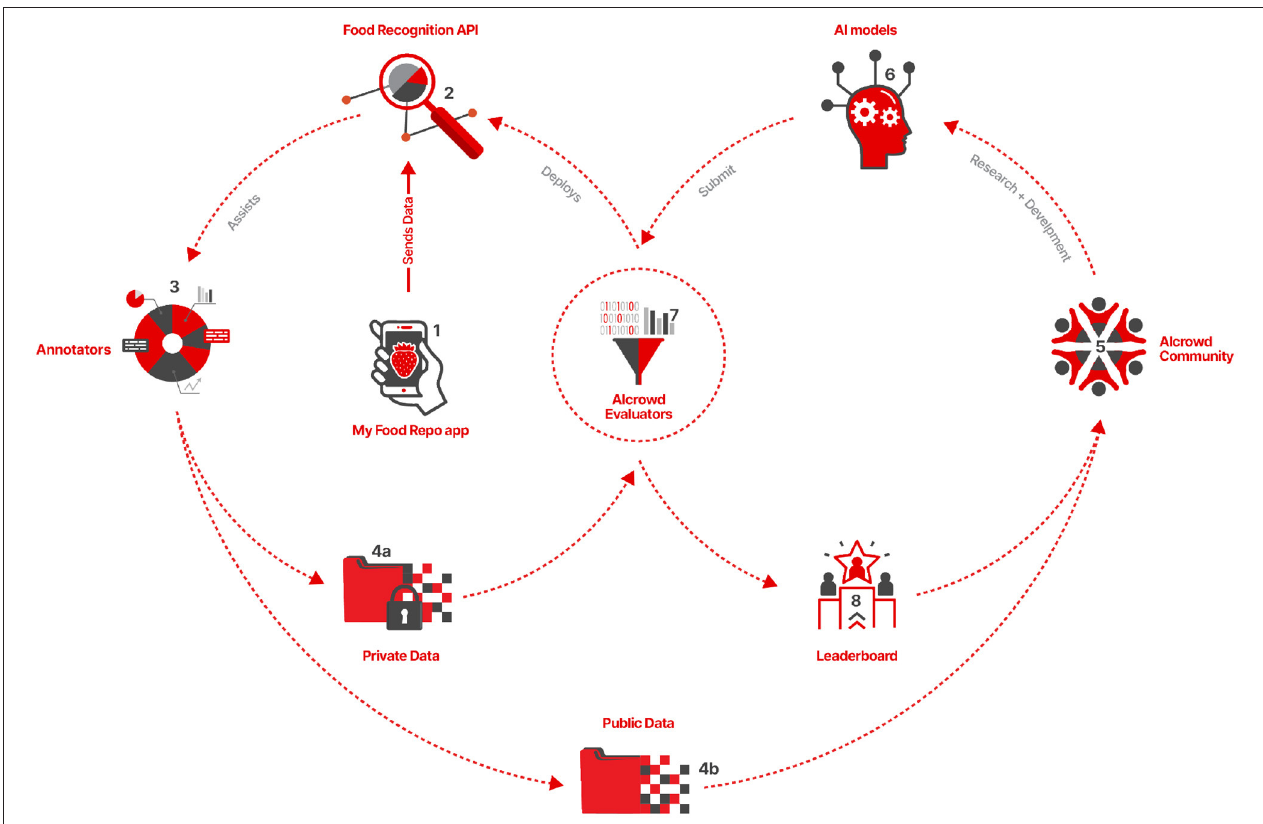
FIGURE 7 | A high level design for Food Recognition Benchmark. Section 2.2.1 contains a detailed explanation of the all the individual components of the Benchmark and how they interact with each